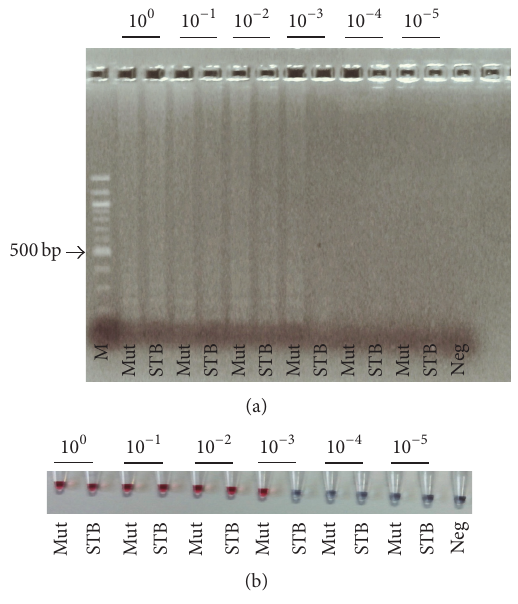
Figure 3: Determining the DNA templates for LAMP of MDR- TB members via the Au-nanoprobes assay. (a) Agarose gel showed LAMP products. Lane 1 (M): Ladder DNA marker; Lanes 1–12: DNA templates for LAMP at 10 0 –10 −5 , Mut as MDR-TB, STB as H37RV, and Neg as negative. All LAMP products were electrophoresed on 2% agarose gels and stained with MaestroSafe Nucleic Acid Gel Stain Sample (Maestrogen). (b) Corresponding results recorded visually after salt challenge. Red colour showed the presence of the target and purple indicated its